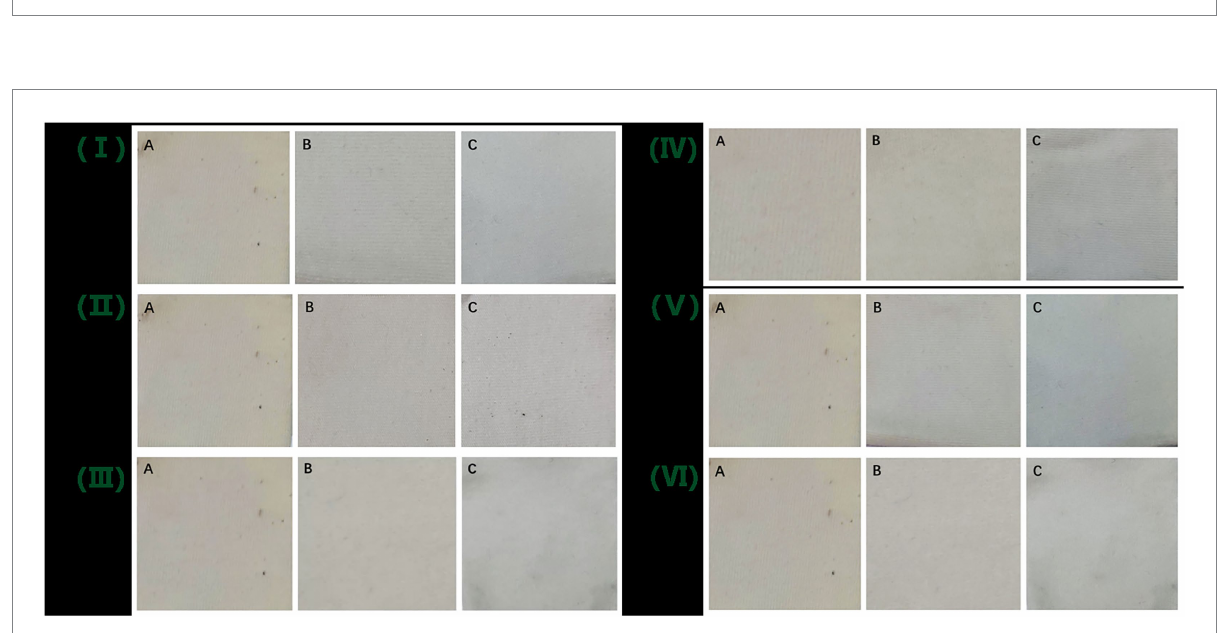
FIGURE 7 Oil-stain removal abilities of Lip54q added to several common commercial detergents on cotton cloth. Three pieces of white cotton cloth with the same size (4 cm × 4 cm) were soaked in cooking oil for 24 h and then removed to dry naturally. Next, they were numbered as A, B, and C and treated as follows: A. white cloth + tap water, B. white cloth + tap water + detergent, and C. white cloth + tap water + detergent + Lip54q (5 U). The detergents used in this experiment included Tide washing powder (I), Blue Moon laundry detergent (II), Liby laundry detergent (III), Walch hand sanitizer (IV), Axe dish soap (V), and Liby dish soap (VI). The cotton cloths were washed for 30 min using the above treatment methods and then air-dried, and the residual oil stains on the three pieces of white cloth were